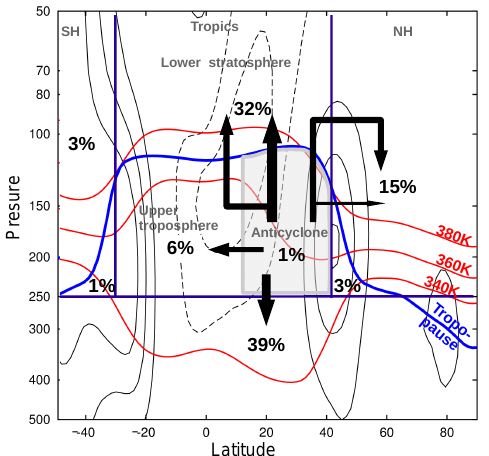
Figure 14. Schematic of the most prominent transport pathways of air originating in the upper-tropospheric anticyclone around 360K (gray box). Numbers indicate fraction of trajectories (in percentage) that are located in the respective regions after 60 days for diabatic transport. The width of the arrows reflects the importance of the re- spective pathway. Contours show the zonal mean wind (black solid: positive; black dashed: negative), the tropopause (blue) and the 340, 360 and 380K isentrope (red) averaged over 20–120 ◦